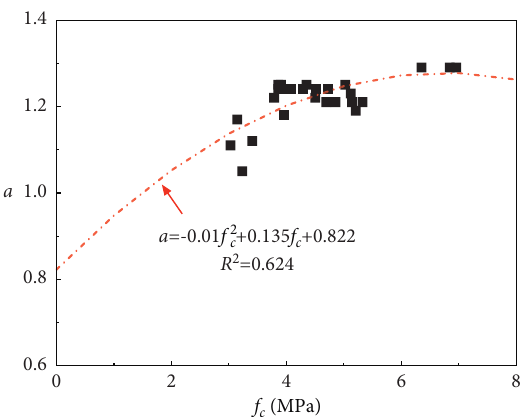
Figure 21: Relations between parameter a and f